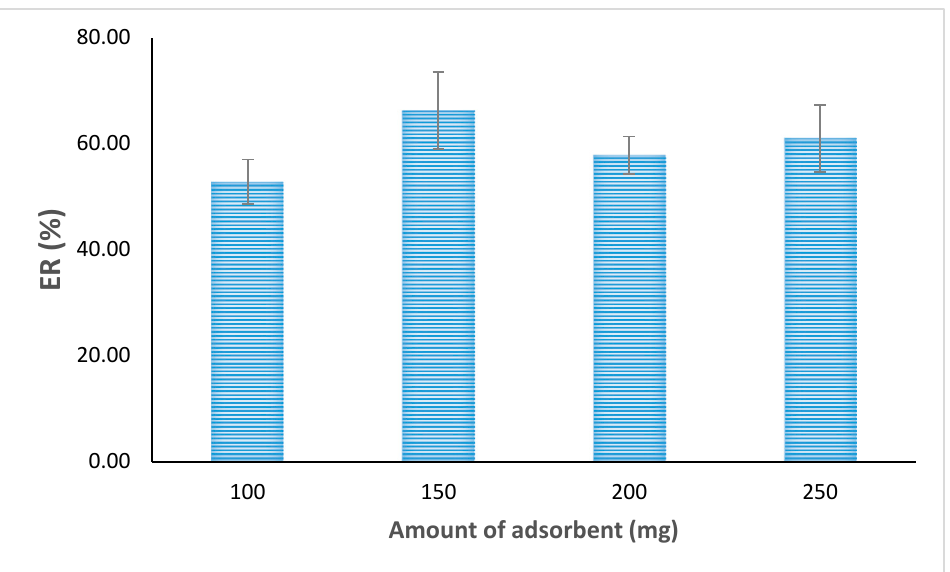
Figure 6. The outcome of the amount of adsorbent on % recovery of pantoprazole. Quantitative aspects: The “calibration curves” (CCs) made by amending the selected analyte (pantoprazole) in distilled water samples were on a scale of 0.05–50 ng/mL.